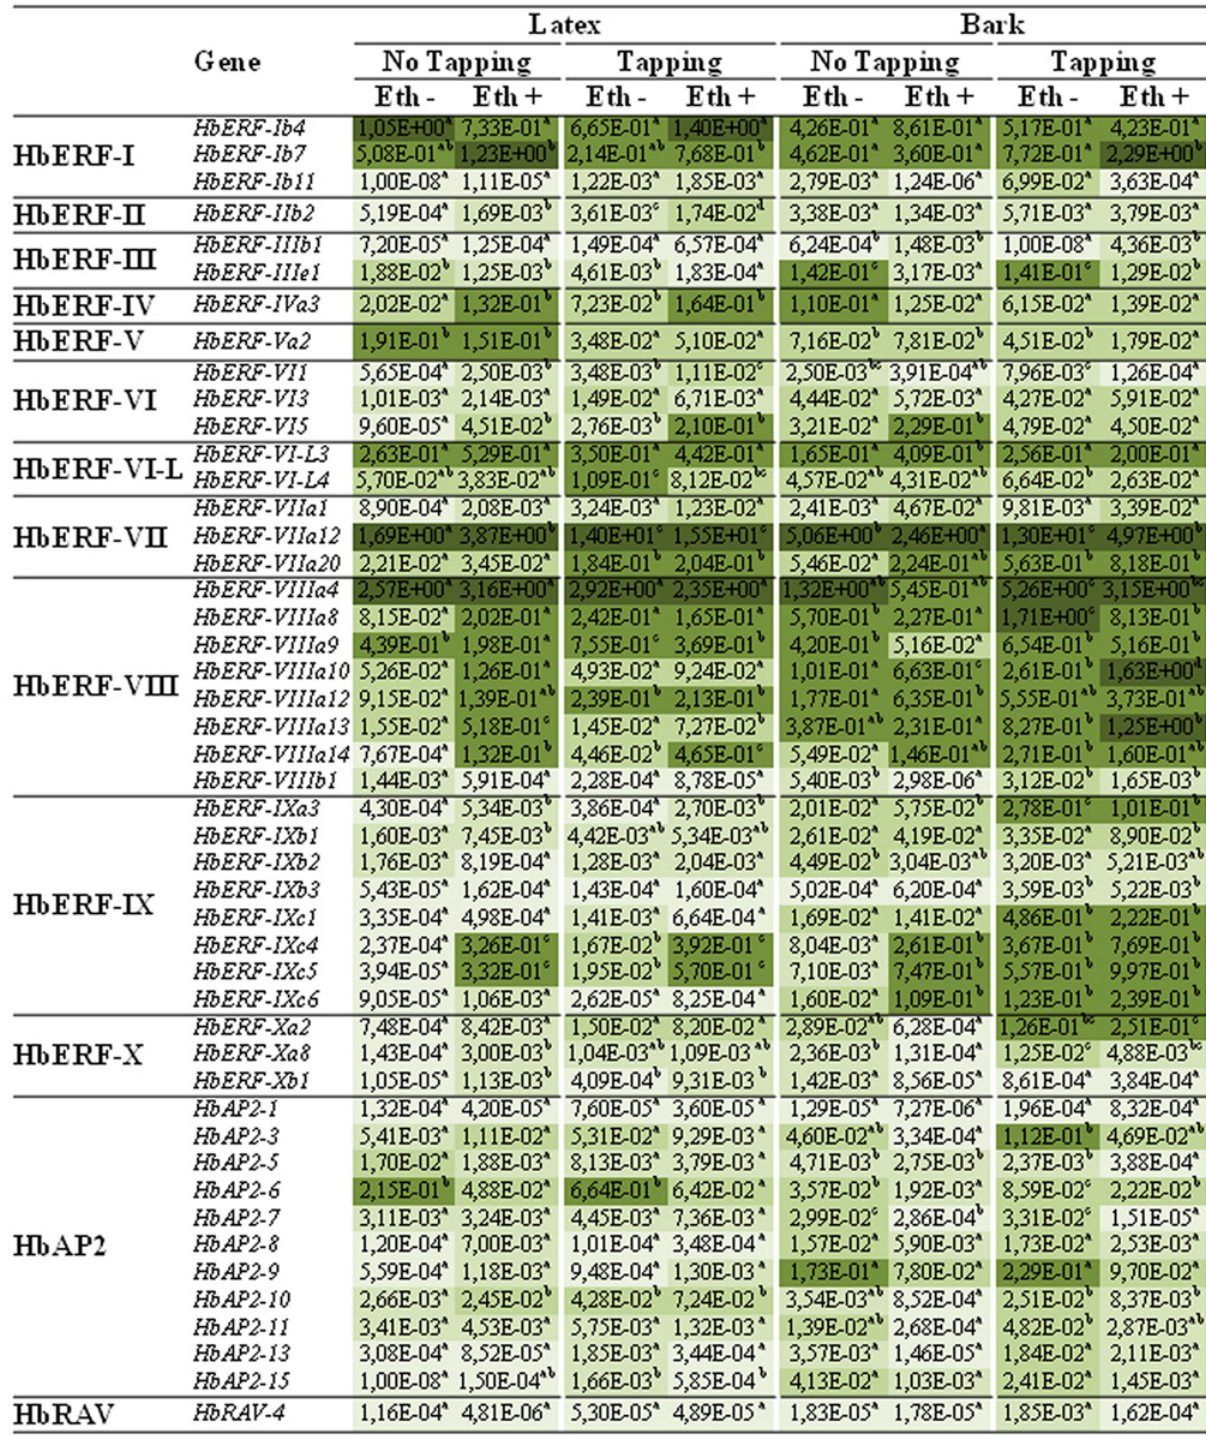
Fig 1. Relative transcript abundance profile of 47 AP2/ERF genes of Hevea brasiliensis in latex and bark tissues of mature trees during latex harvesting. Tapping without ethephon (Eth-) and with ethephon (Eth +) were applied in both studied tissues. Heat map representation was used for values ranging as follows (cid:1) 1, 10 – 1, 10 – 2, 10 – 3 and (cid:3) 10 – 4 from dark to light green.